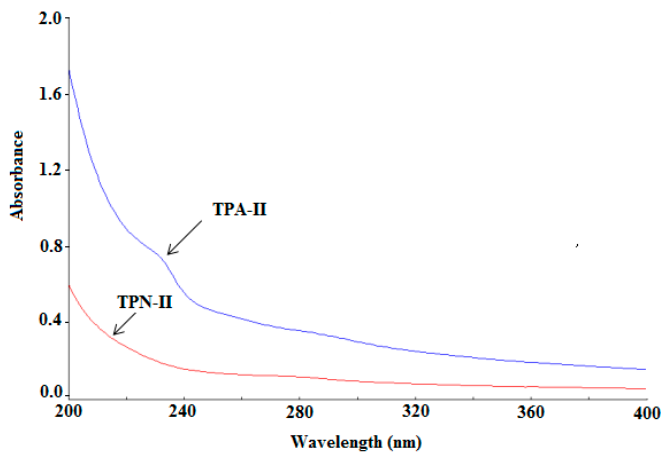
Figure 4. Ultraviolet (UV) spectrum of neutral fraction of total polysaccharides-II (TPN-II) and acidic fraction of total polysaccharides-II (TPA-II).